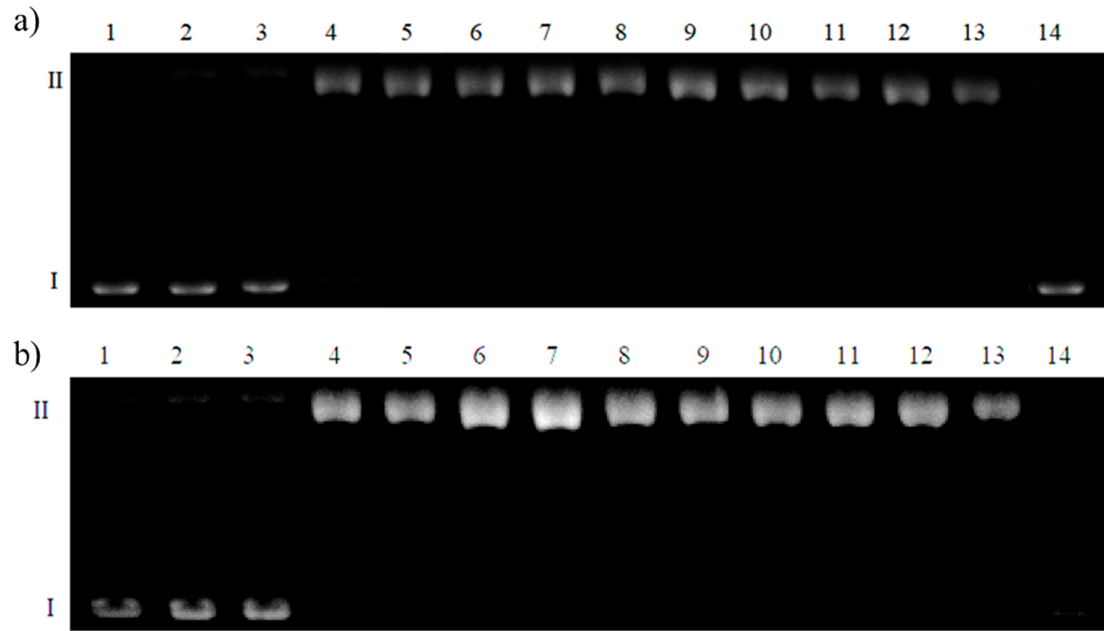
Figure 7. Degradation of plasmid DNA in the presence of copper(II) complex with ( a ) Ac-AKGHEHQLE-NH 2 (L 1 ) and ( b ) Ac-FGEHEHGRD-NH 2 (L 2 ) in the presence of 50 µ M H 2 O 2 . The samples were incubated for one hour at 37 ◦ C. Lane 1: plasmid; lane 2: plasmid + 10 µ M Cu(II) + 50 µ M H 2 O 2 ; lane 3: plasmid + 10 µ M complex + 50 µ M H 2 O 2 ; lane 4: plasmid + 20 µ M Cu(II) + 50 µ M H 2 O 2 ; lane 5: plasmid + 20 µ M complex + 50 µ M H 2 O 2 ; lane 6: plasmid + 50 µ M Cu(II) + 50 µ M H 2 O 2 ; lane 7: plasmid + 50 µ M complex + 50 µ M H 2 O 2 ; lane 8: plasmid + 100 µ M Cu(II) + 50 µ M H 2 O 2 ; lane 9: plasmid + 100 µ M complex + 50 µ M H 2 O 2 ; lane 10: plasmid + 500 µ M Cu(II) + 50 µ M H 2 O 2 ; lane 11: plasmid + 500 µ M complex + 50 µ M H 2 O 2 ; lane 12: plasmid + 1000 µ M Cu(II) + 50 µ M H 2 O 2 ; lane 13: plasmid + 1000 µ M complex + 50 µ M H 2 O 2 ; lane 14: plasmid + 1000 µ M ligand + 50 µ M H 2 O 2